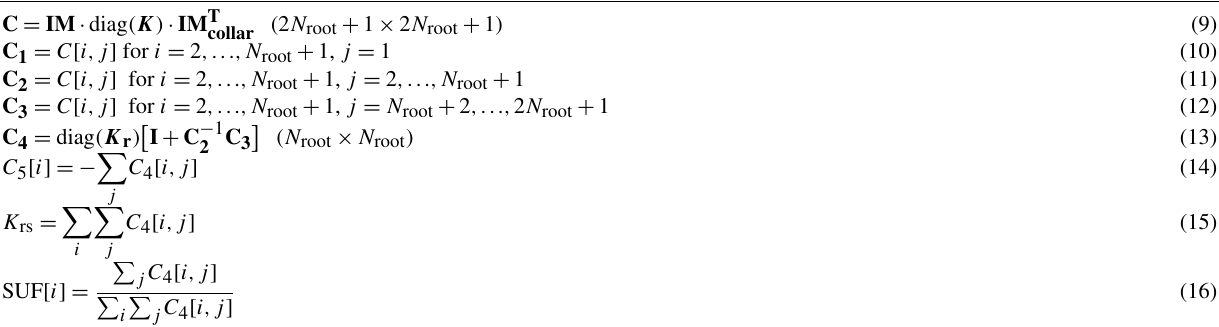
Table 1. Equations to calculate the root system hydraulic conductance, K rs , the standard uptake fraction, SUF, and the compensatory uptake matrix, C 4 , from the hydraulic root